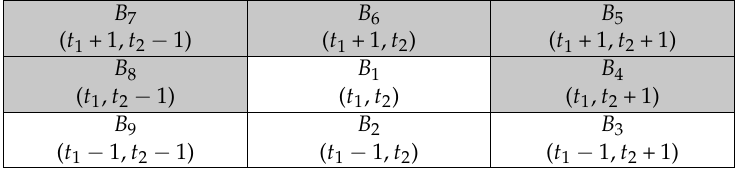
Table 1. Designations of the nine pixels in a 3 × 3